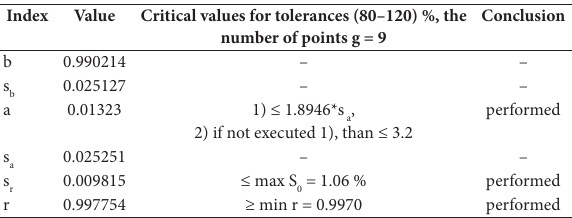
Table 5. Metrological characteristics of linear data.